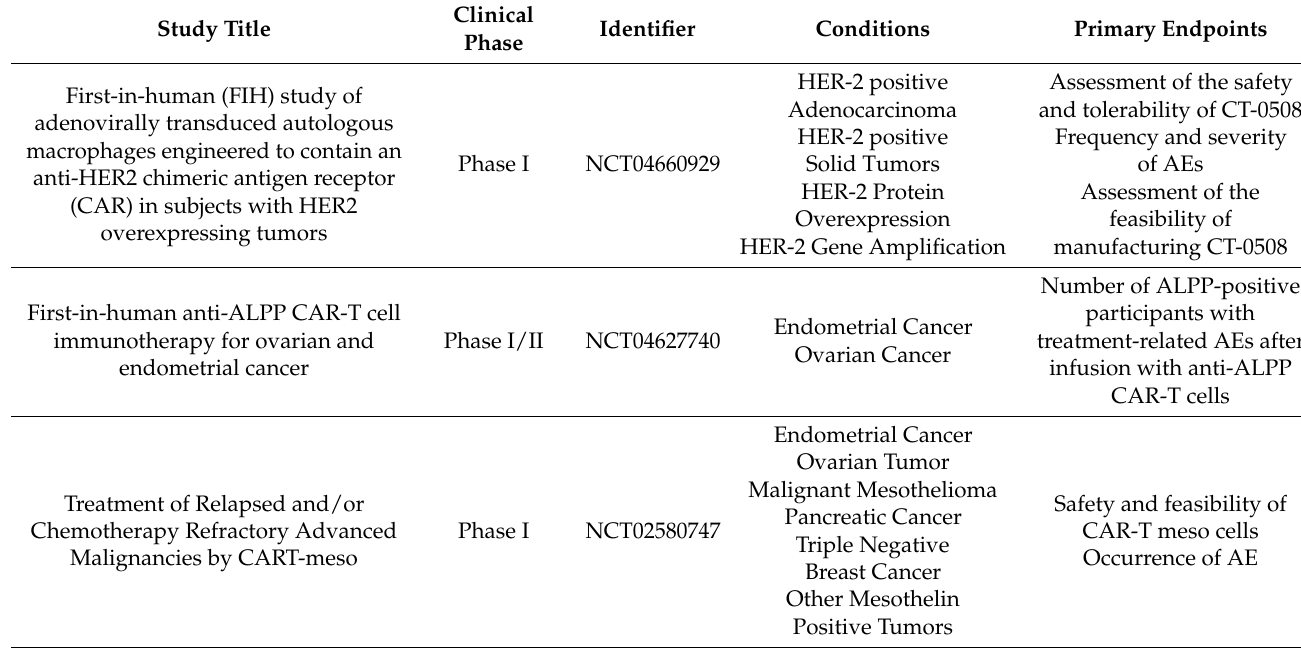
Table 1. Ongoing studies regarding CAR-T cell therapy against endometrial